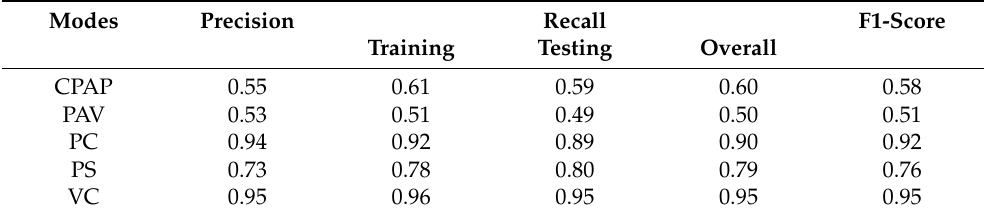
Table 11. Model evaluation report for KNeighbors algorithm. Modes